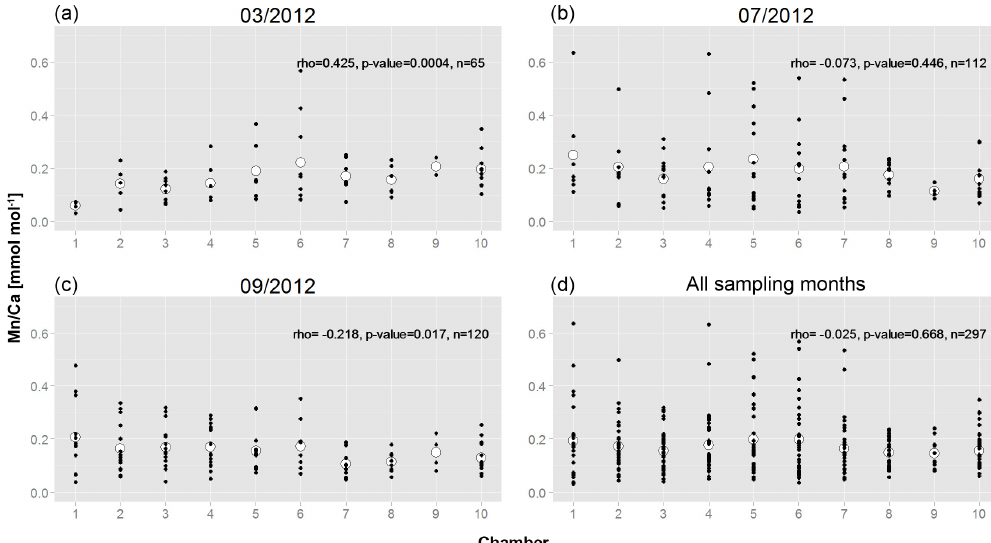
Figure 5. Mn / Ca of all measured specimens as a function of chamber succession. (a) March; (b) July; (c) September; (d) all combined. Numbers on x axis indicate chambers: 1 – penultimate chamber; 2 – antepenultimate chamber, etc.; 10 – central part of test. Small black dots represent Mn / Ca of single measurements; larger white circles represent average values per chamber, when all specimens are combined. Trends were tested for statistical significance with a Spearman rank correlation (correlation coefficient rho, p value and n (total number of data points) are